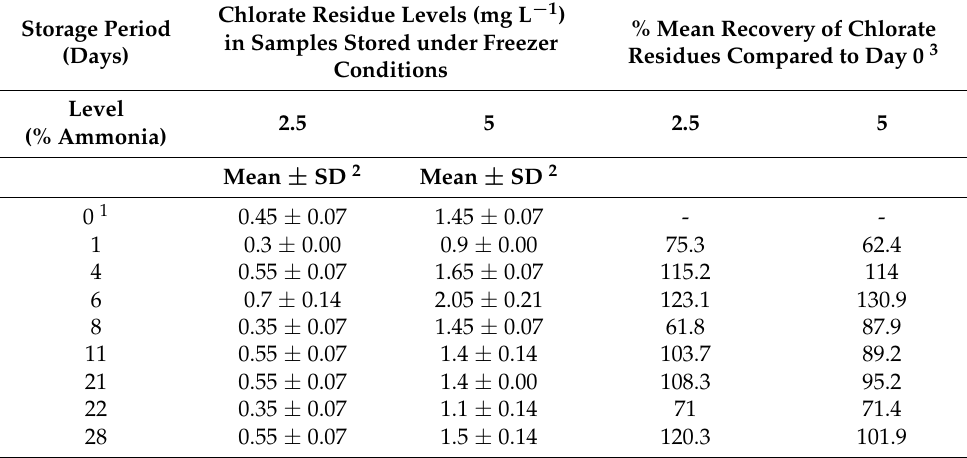
Table 5. Summary results of the 28-day storage stability study of chlorate residues in the nutrient solutions with 2.5 and 5% ammonia concentration. The nutrient solution was composed to support the fruiting of an open soilless system cultivation of